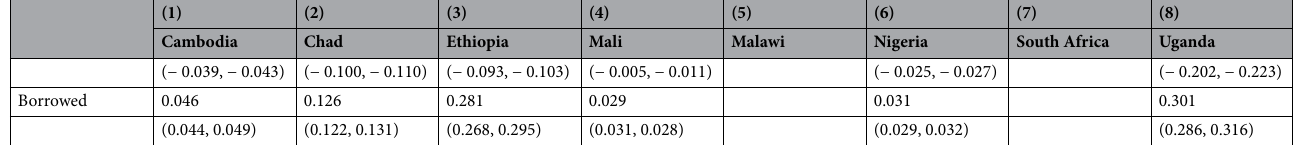
Table 4. Determinants of food insecurity—ran out of food. 95% CI in